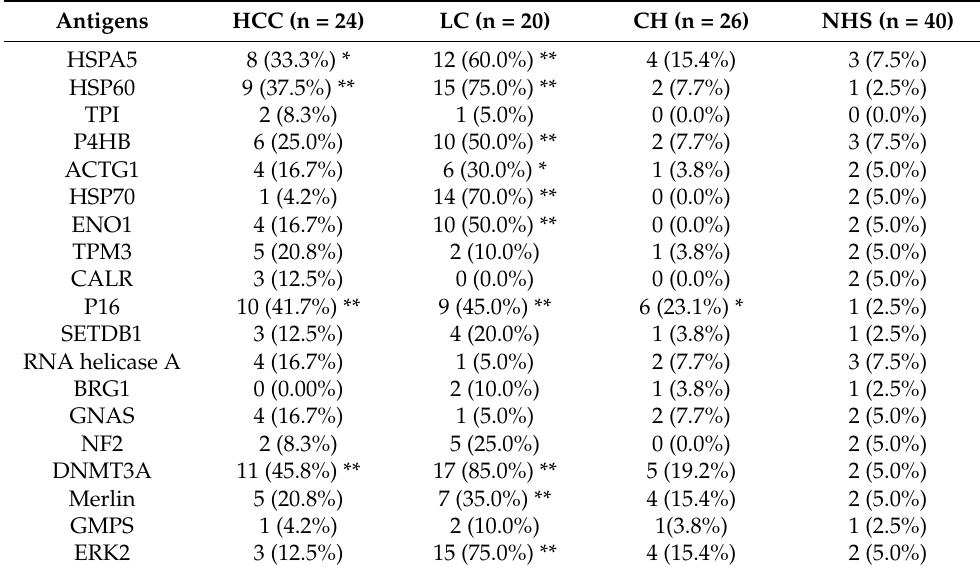
Table 3. Frequencies of autoantibodies against nineteen potential